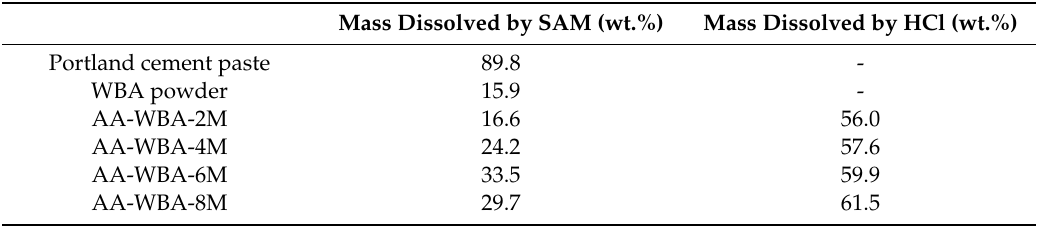
Table 4. Salicylic acid/methanol (SAM) and HCl extraction results. Mass Dissolved by SAM (wt.%) Mass Dissolved by HCl (wt.%)